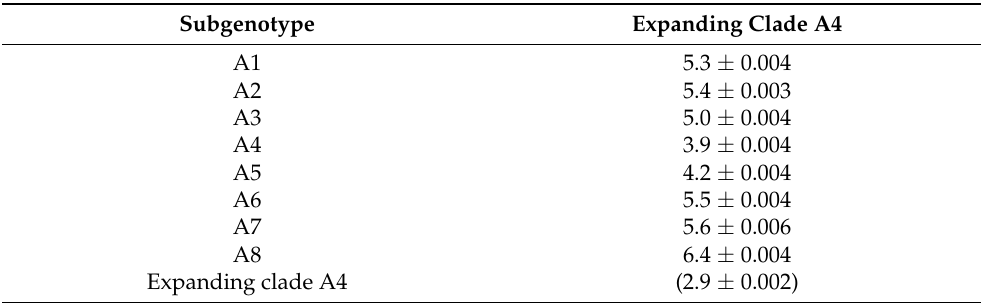
Table 1. Percentage (mean ± SD) of nucleotide divergence between Hepatitis B virus (HBV) subgeno- type A full sequences and expanding clade of subgenotype